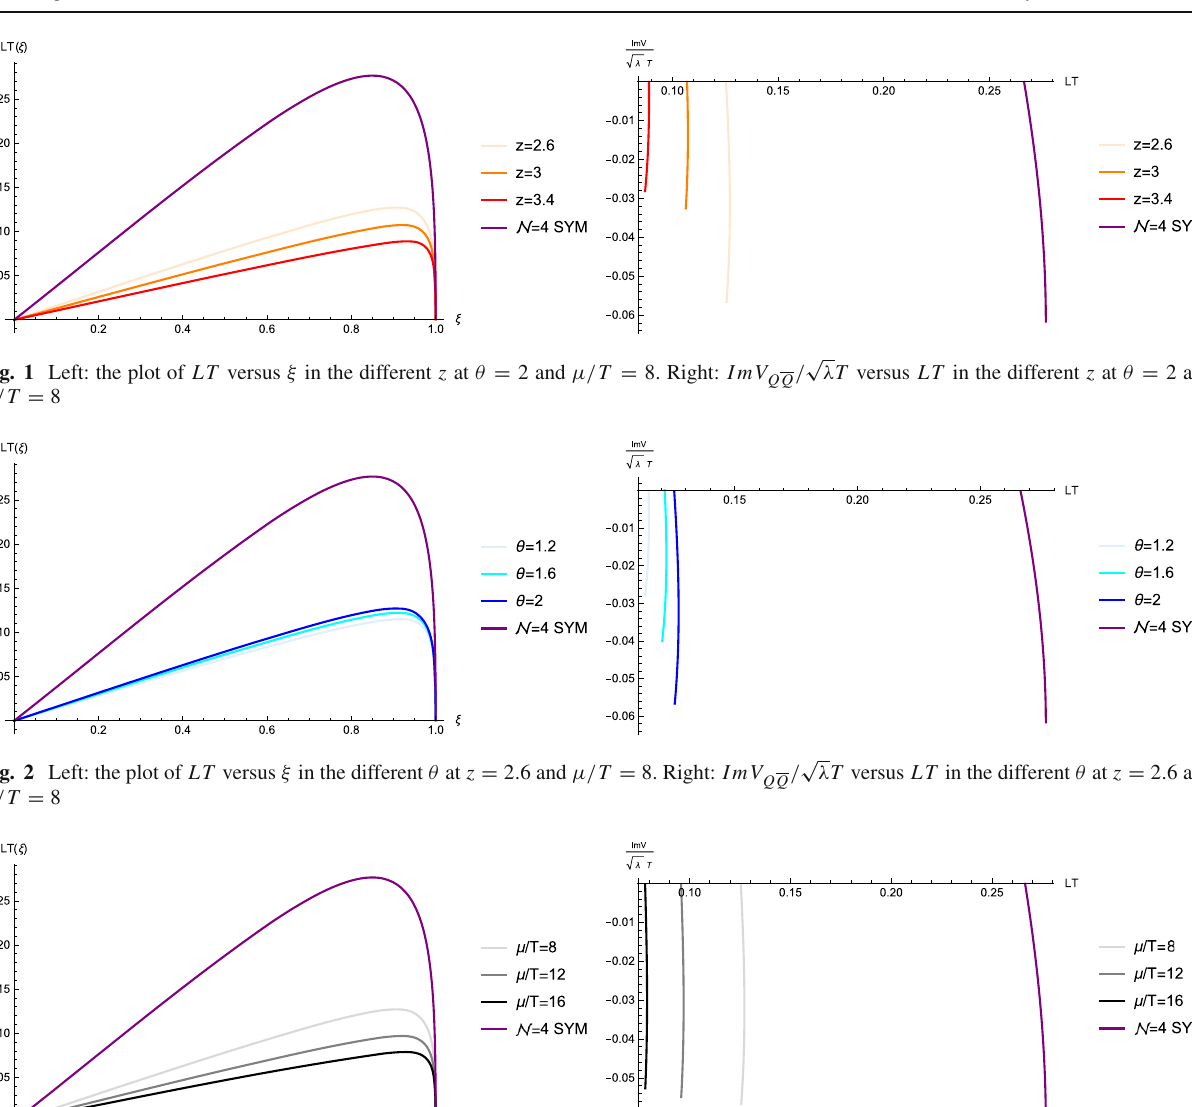
√ / λ T versus LT in the different μ/ T at θ = 2 QQ